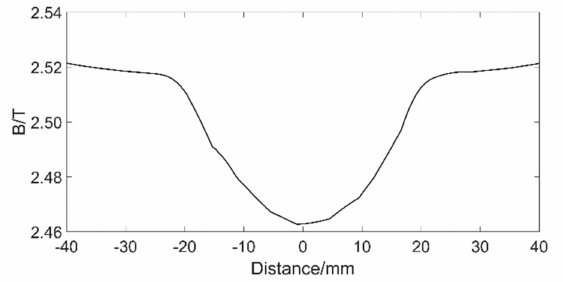
Figure 8. Magnetic flux density of the wire rope with L m = 180 mm.